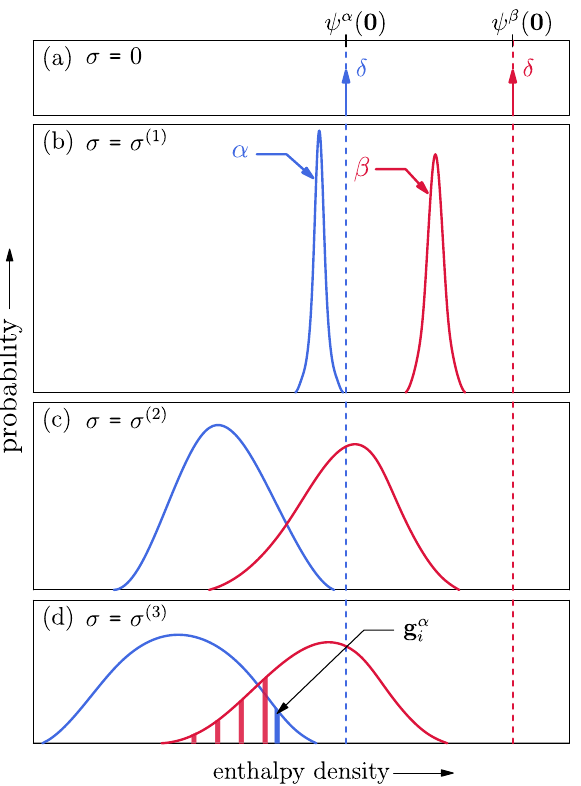
Fig. 2 A schematic of stress dependence of the enthalpy density distribution. a At zero stress, all grain orientations have the same enthalpy density equal to the chemical binding energy density of the stress-free state ψ ( E e = 0 ). b – d Enthalpy density distributions for increasing stress. d Transformation from a parent grain (blue bar) with orientation g α i to variants in daughter phase orientations restricted by an OR (red bars). Table 1 Basal and prismatic orientation relations for fcc – hcp and the Burgers orientation relation for bcc – hcp